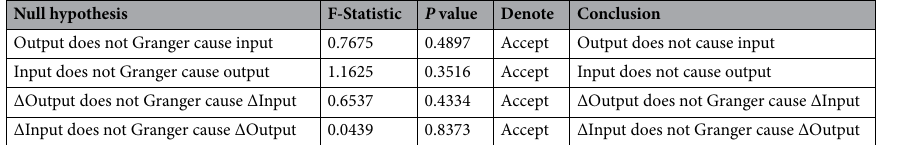
Null hypothesis